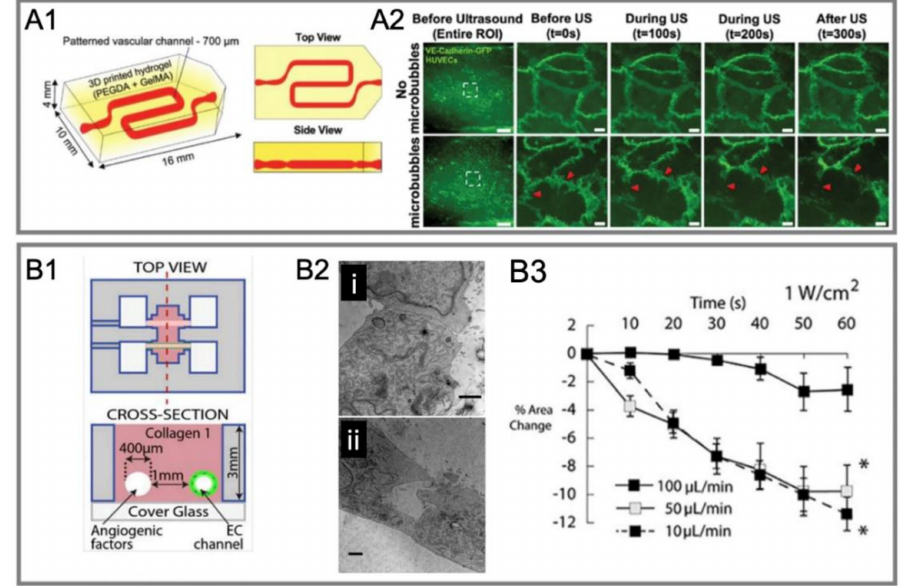
Figure 11. Recent studies on ultrasound-mediated opening of vascular barriers in three-dimensional BOC. ( A1 ) A perfusion-based 3D printable hydrogel vascular model for culturing HUVEC [126]. ( A2 ) Live imaging of endothelial cell–cell junctions under ultrasound exposure [126]. ( B1 ) A 3D model where channels were fabricated by micro-needles [125]. ( B2 ) Transmission electron microscopy for testing conditions of ( i ) 0.5 W/cm 2 ultrasound intensity and 100 µ L/min fluid flow and ( ii ) 1 W/cm 2 ultrasound intensity and 10 µ L/min fluid flow. ( B3 ) The influence of different flow rates on the cell area reduction under acoustic intensity of 1 W/cm 2 [125].